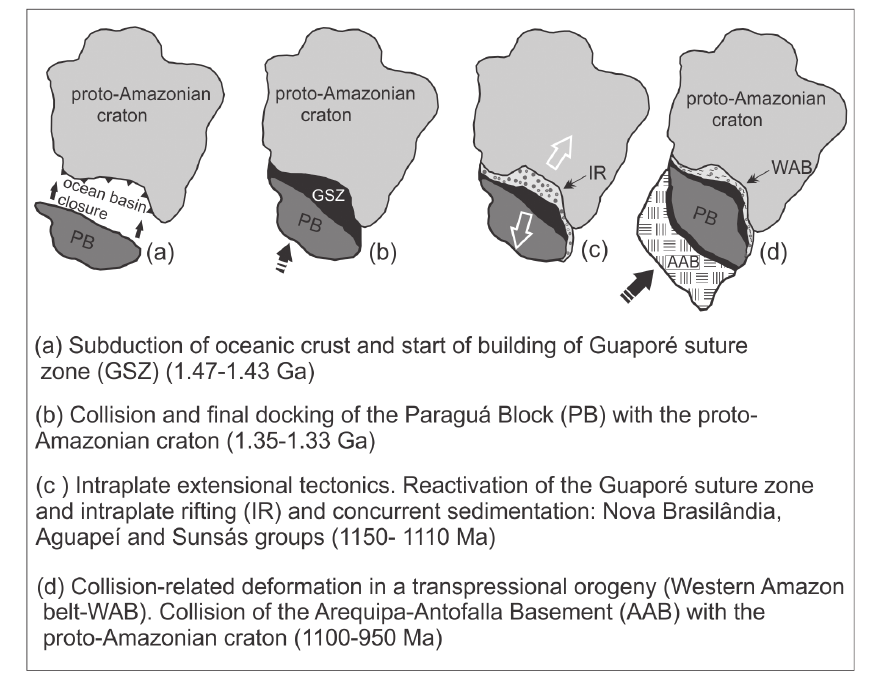
Figure 6 - Hypothetical simplified sketch, showing proposed tectonic evolution of the southwestern Amazonian craton in Mesoproterozoic time (modified of Boger et al.